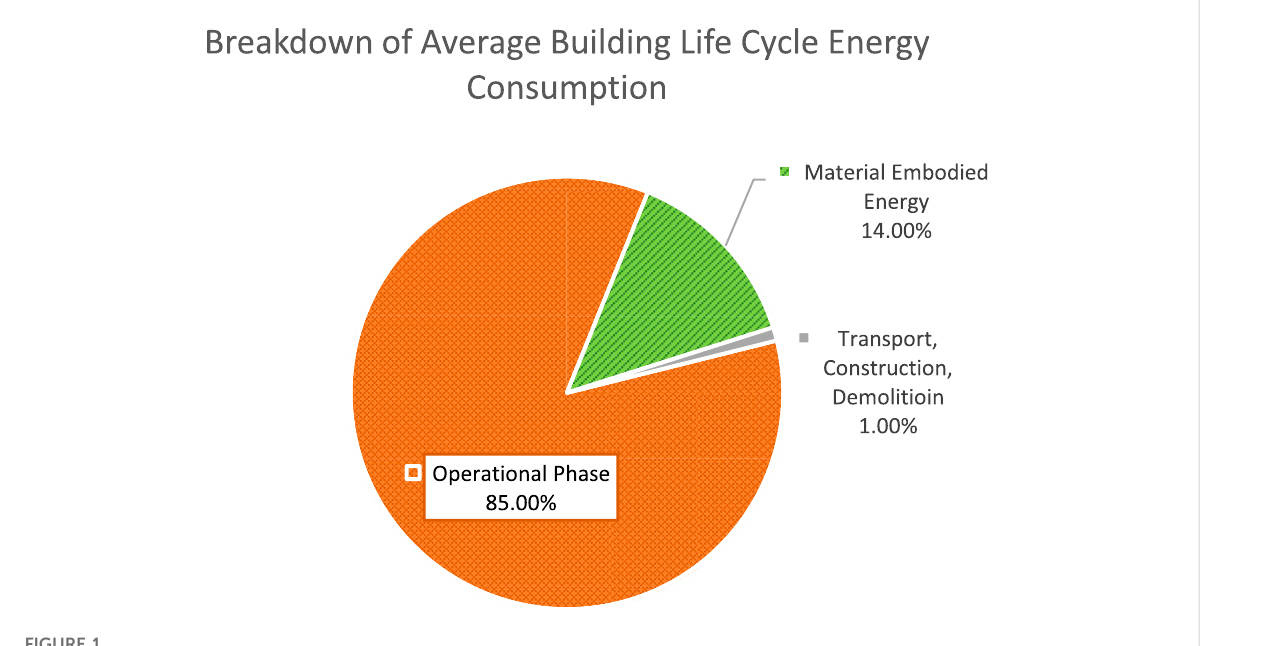
FIGURE 1 Breakdown of average building life cycle energy consumption